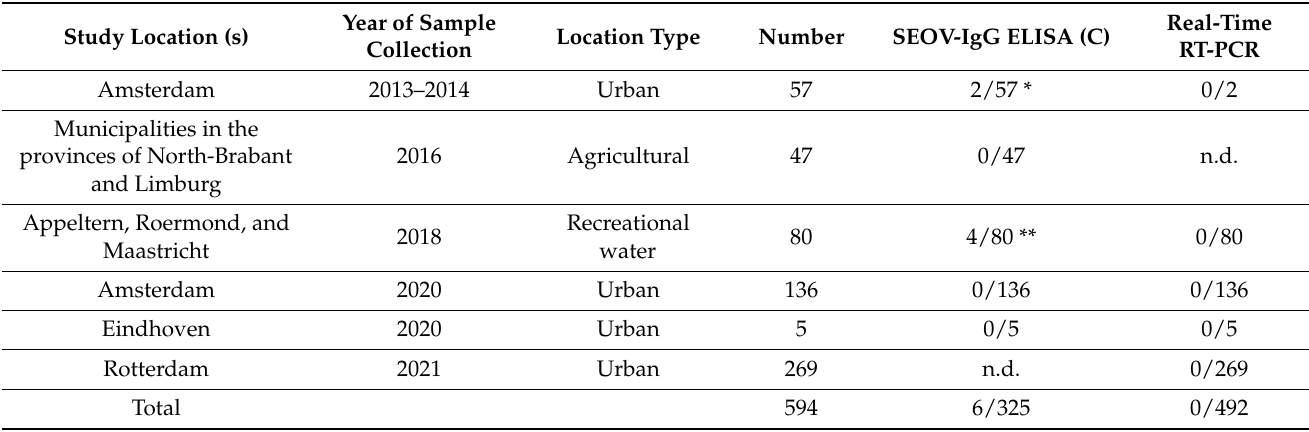
Table 4. Results of serological and real-time RT-PCR analyses of wildlife rats from different geographic regions in the Netherlands (Panel